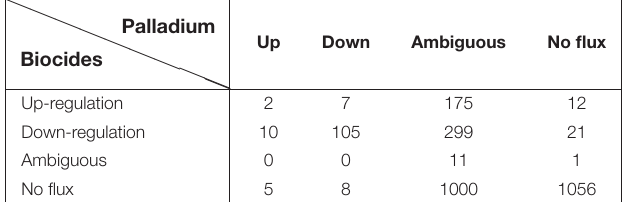
TABLE 5 | Similarity of stress responses.